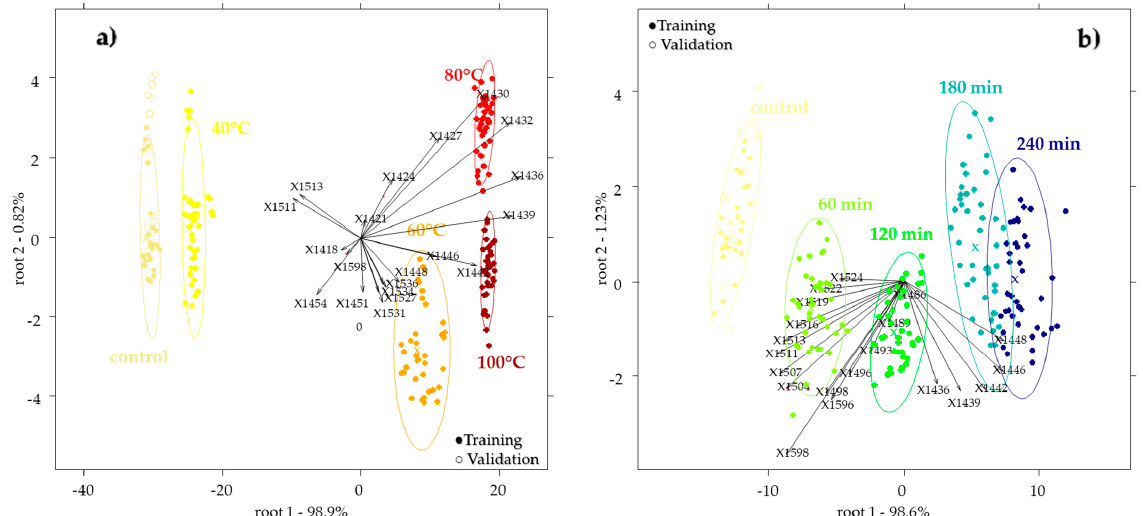
Figure 3. PCA-LDA score plot of the sunflower honey with the 20 most important loadings: ( a ) temperature classification model of honeys treated for 60 min with a Savitzky–Golay smoothing (window size 21) and SNV pretreatment; ( b ) time classification model of honey heated at 40 °C with Savitzky–Golay smoothing (window size 13), MSC and detrending pretreatment. Table 2. PCA-LDA classification accuracies of the detailed temperature level and time interval classification models.